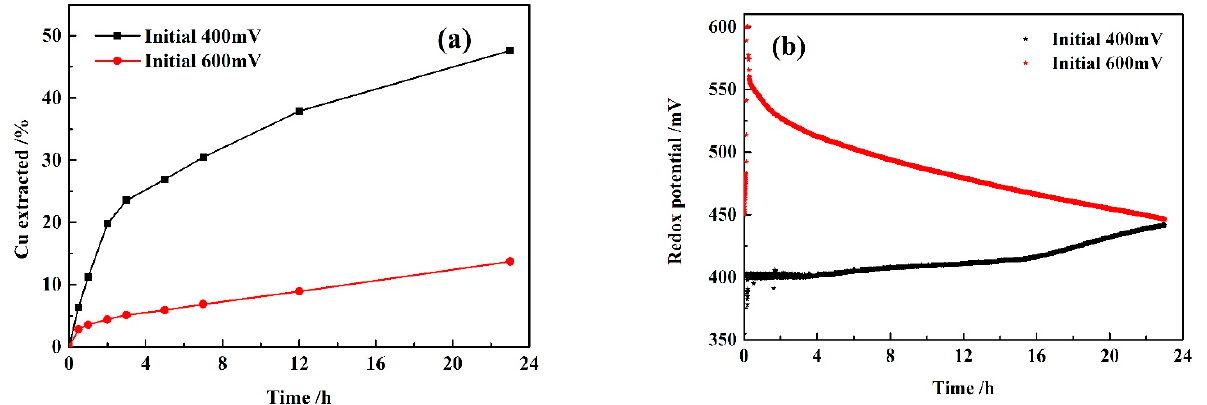
Figure 3. Cu leaching rate ( a ) and real-time redox potential data of the leaching solution ( b ), with initial redox potentials of 400 mV and 600 mV, respectively; the redox potential was not fixed in the test process.